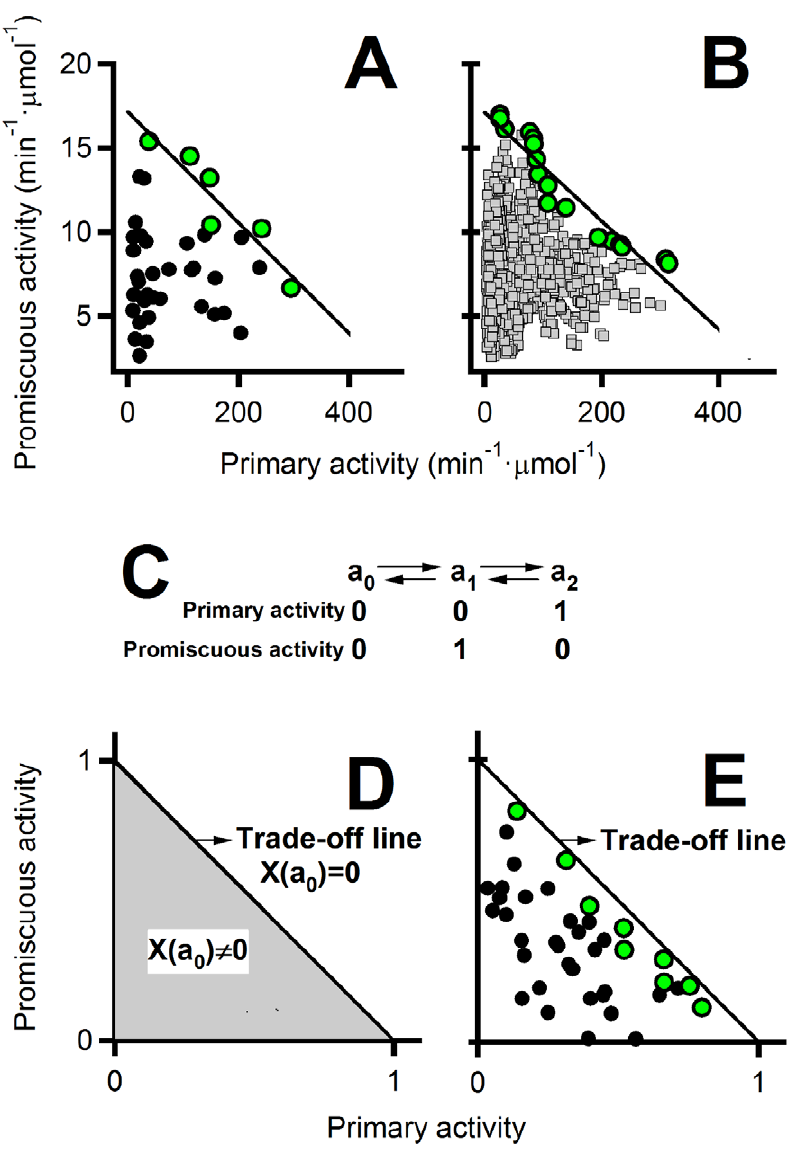
is analogous to that in Figure 5F but linear activity scales (instead of logarithms) are used here and error bars have been omitted for the sake of clarity. The line represents the least-squares fit to the Pareto set data. (B) A partial least squares reconstruction of the data for the whole combinatorial library based on the experimental data of panel A. The data shown correspond to a single bootstrapping replica; however, other replicas show the same general pattern The Pareto set (green points) and the corresponding linear fit are shown. (C) Simple conformational diversity model used in the simulation summarized in panels D and E. Conformation a 0 is not active, while conformations a 1 and a 2 are responsible for the promiscuous and primary activities, respectively. (D) Relevant regions in the primary/promiscuous activity diagram according to the model shown in panel C. Optimal situations correspond to a zero mol fraction of the inactive conformation and define a trade-off line in the plot. Sub-optimal situations correspond to a mol fraction of a 0 higher than zero and are located in a triangular-shaped region below the trade-off line. (E) Stochastic simulation of 40-variant set based on the model shown in panel C. The Pareto set (green data points) approaches the trade-off line.